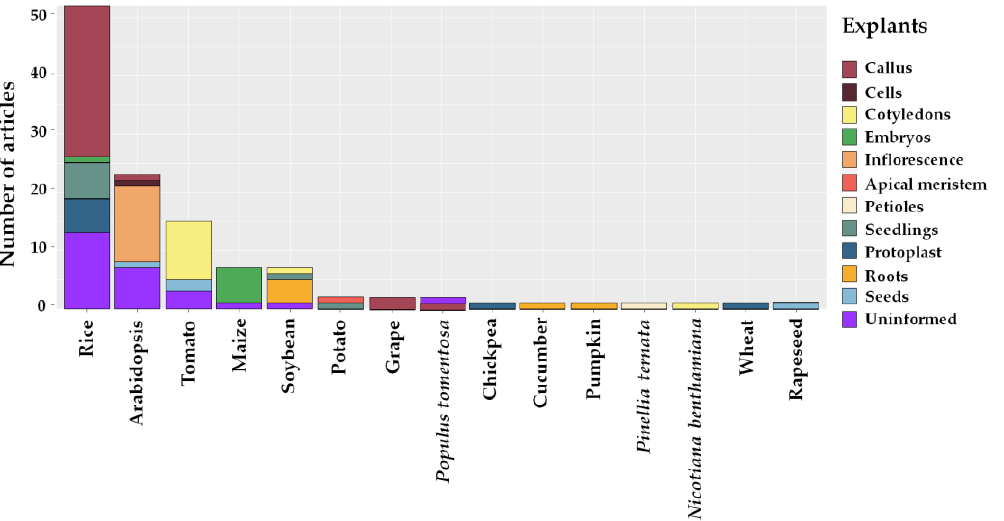
Figure 6. Explants used in studies on gene editing with CRISPR/Cas for tolerance to abiotic stresses in plants in the last seven years.